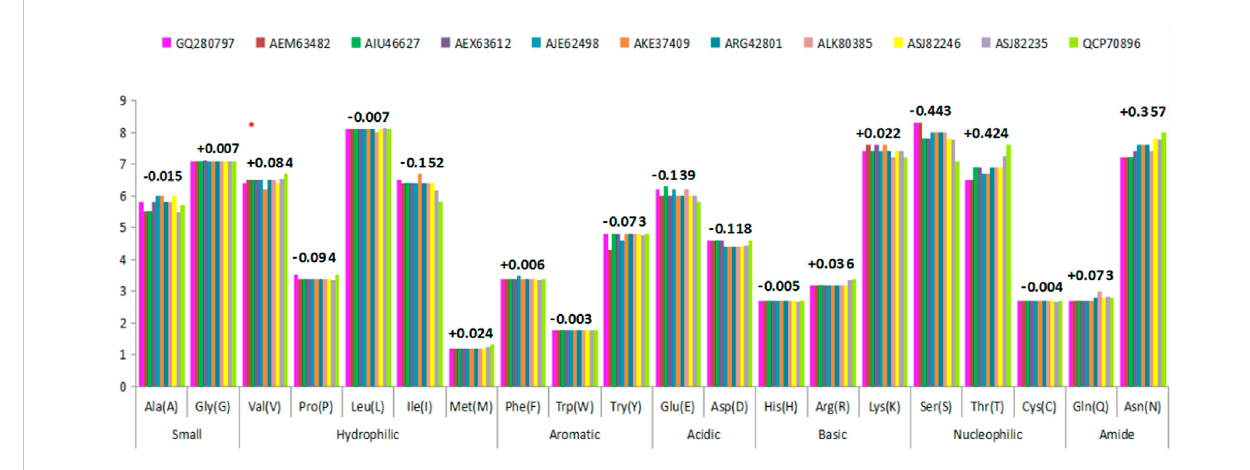
FIGURE 5 Variations observed in amino acid composition due to mutational events in the HA Ind protein sequence circulated during 2009 – 2018 against HA Cal . The numerical values (either with + or – sign) indicate the average variations of mutational